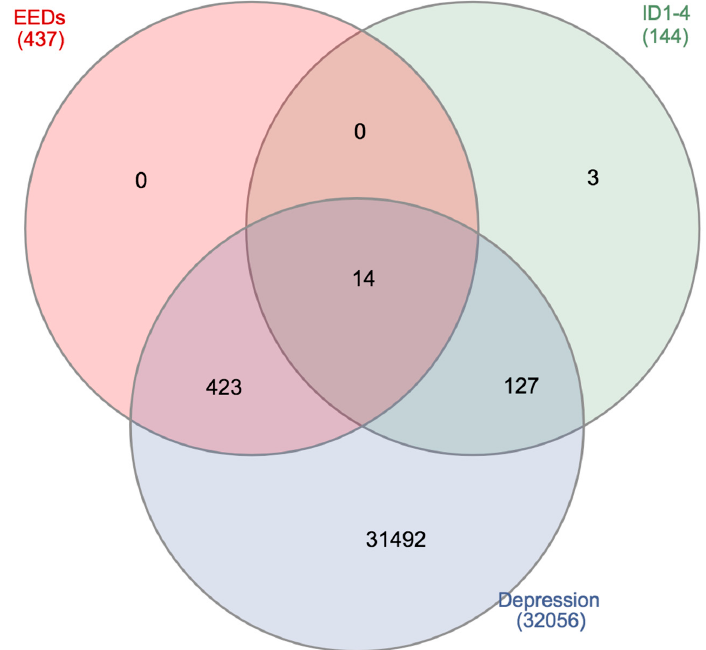
Figure 2. Venn diagram demonstrating the interacting genes between the overlapping estrogenic endocrine disruptors (EEDs; 437 genes), Inhibitor of DNA-Binding/Differentiation (ID) proteins (144 genes), and depression (32056 genes). Results reveal 14 overlapping genes. Table 1. The 14 overlapping, interacting EED–ID protein-depression genes.